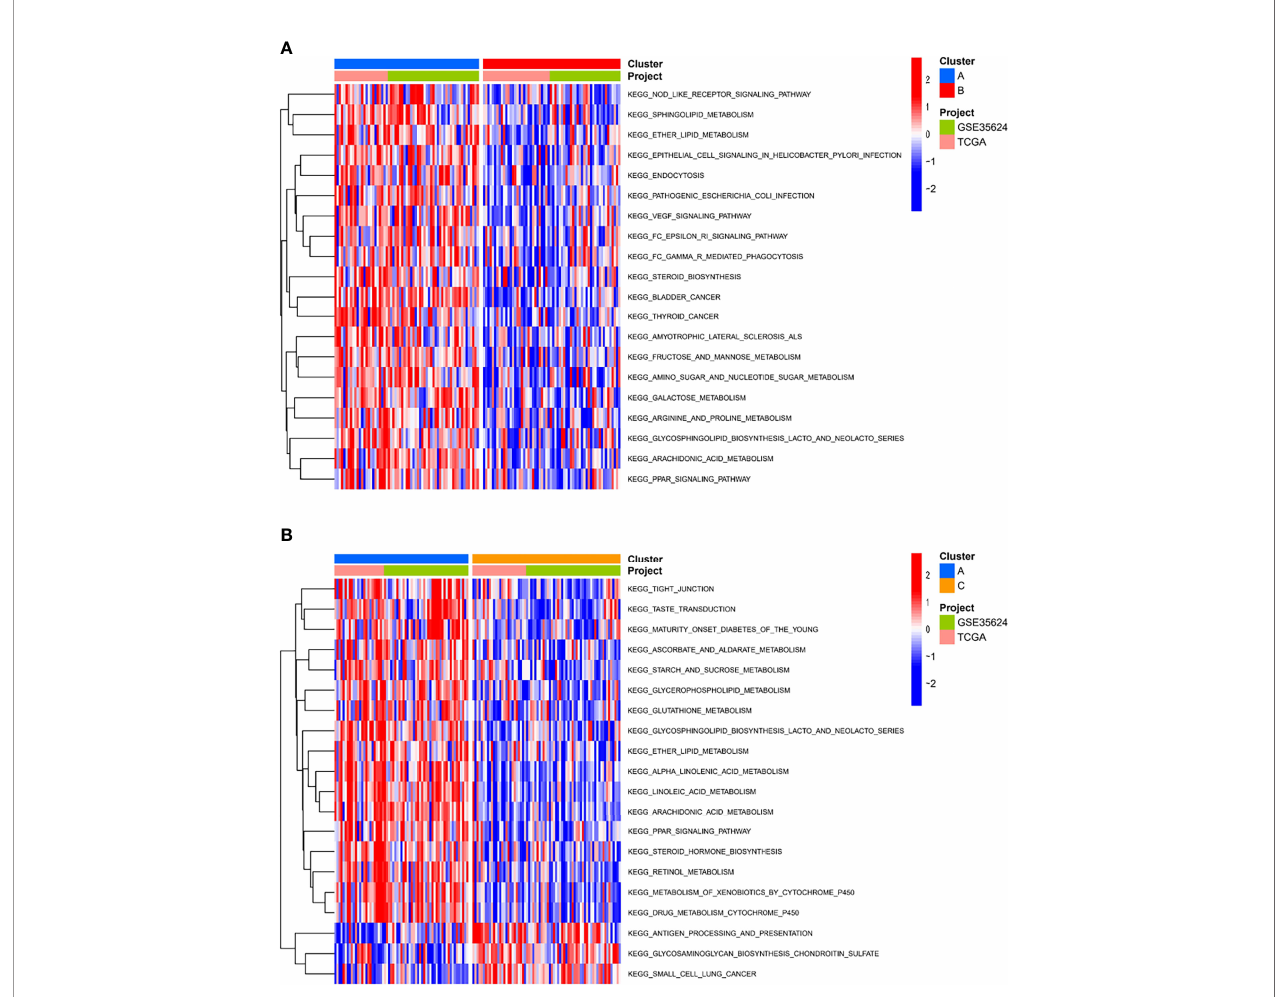
FIGURE 4 | Biological characterization of molecular subtypes. (A, B) The GSVA pathway enrichment analysis between different